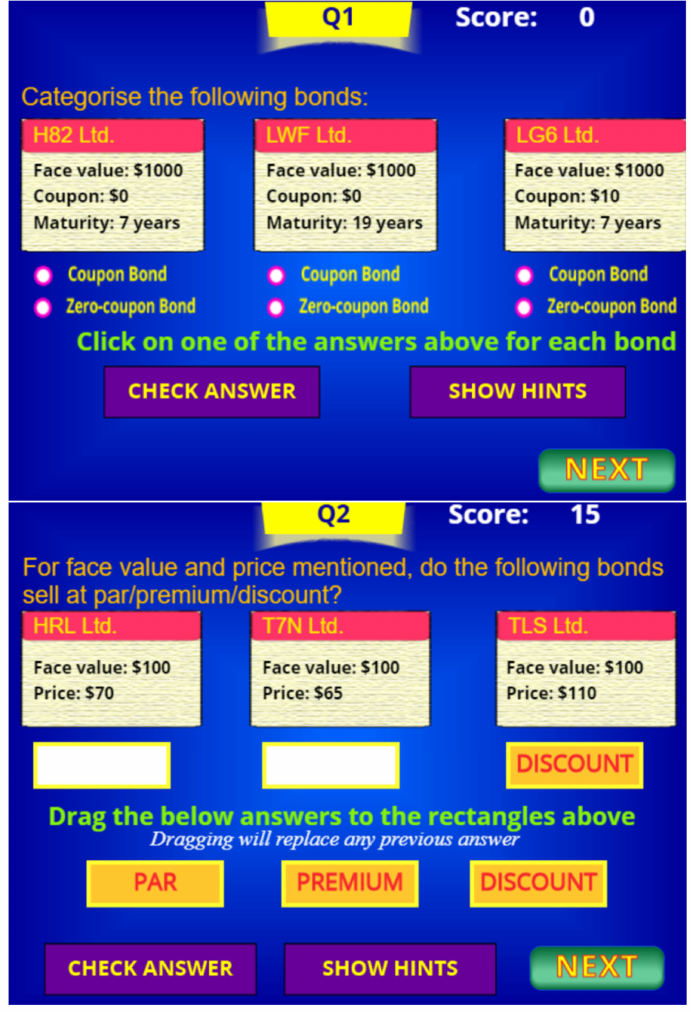
Figure 1. Example interface for two